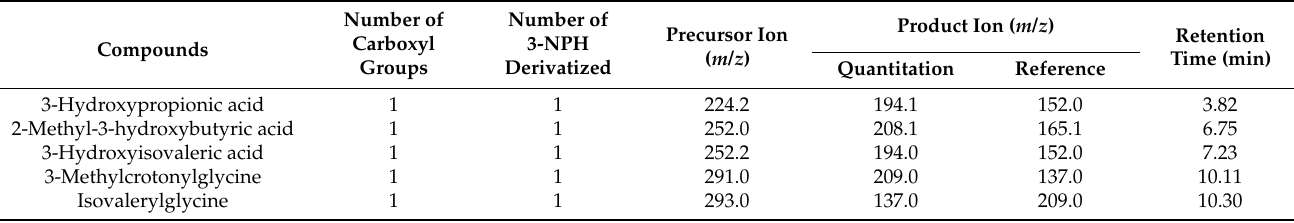
Table 1. Multiple reaction monitoring transitions of 3-Nitrophenylhydrazine (3-NPH) derivatized organic acids. For all compounds, 3-NPH derivatized reaction was found to occur in all carboxyl groups.